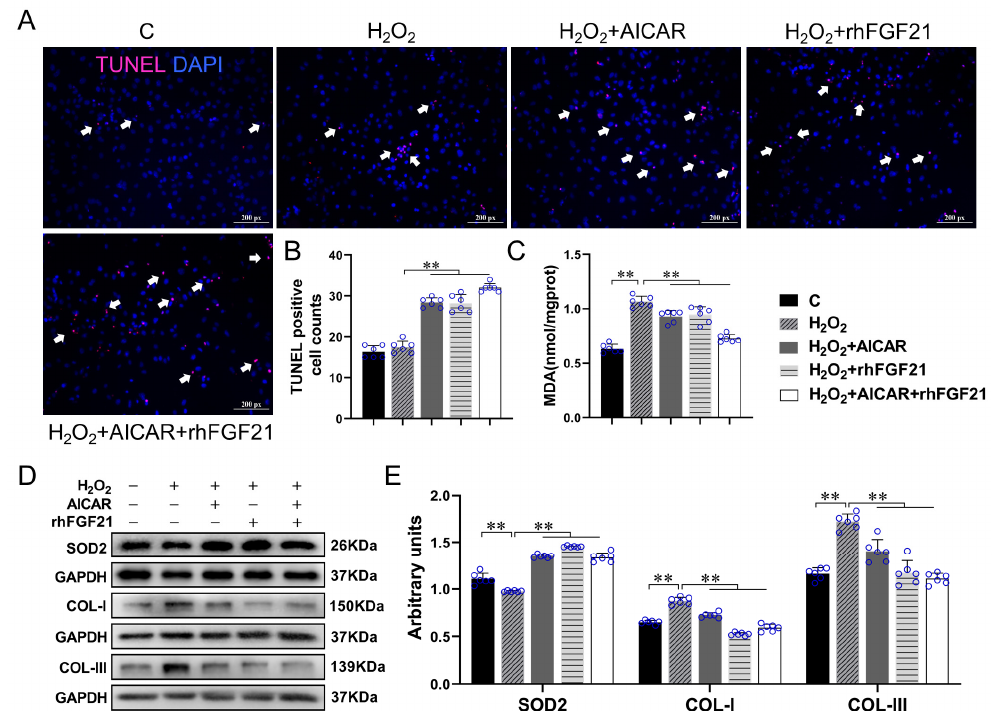
Figure 4. rhFGF21 and/or AICAR induced CFs apoptosis and reduced oxidative stress and fibrosis levels in CFs with H 2 O 2 treatment. ( A ) TUNEL staining; the positive apoptotic particles showed red fluorescence, the nuclei showed blue, scale bar = 200 px; ( B ) statistical analysis of TUNEL staining; ( C ) MDA content of CFs; ( D ) the protein expressions of SOD2, COL- I and COL- III in CFs. ( E ) Statistical analysis. Data are expressed as mean ± Standard Deviation (SD), n = 6. Statistical method: one-way analysis of variance (ANOVA). ** p < 0.01. MDA, Malondialdehyde; C, Untreated control group; AICAR,